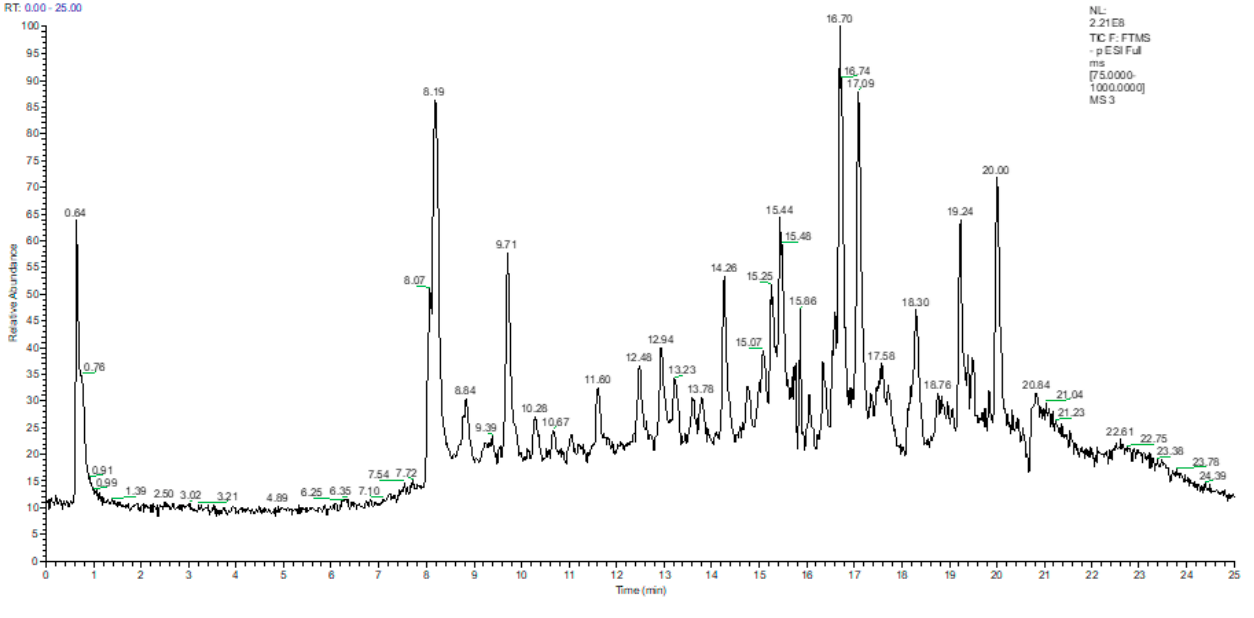
Figure 1. The total ion current (TIC) chromatogram obtained for the separation of targeted phenolic compounds from extra-virgin olive oil liquid extract using UHPLC–MS/MS detection in negative ionization mode.